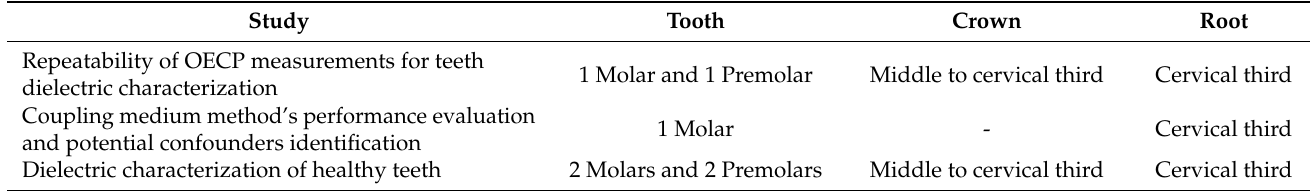
Table 1. Characterization of samples included in each of the